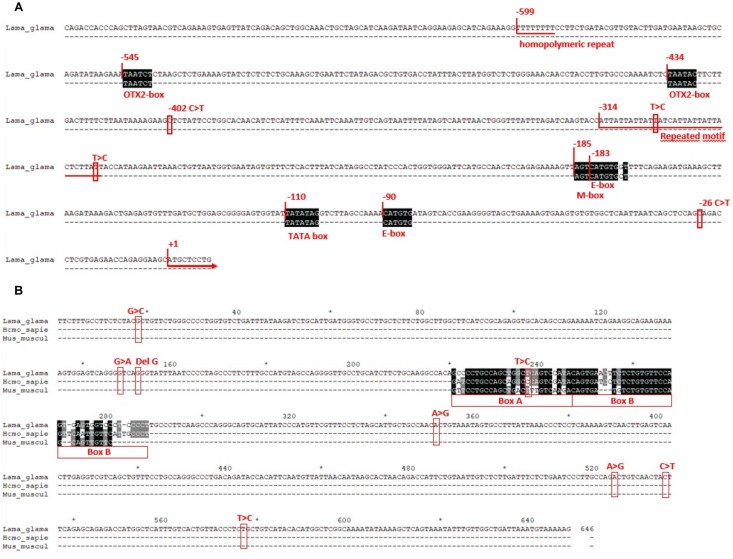
(A) Proximal promoter region of TYR gene. Positions +1 were assigned to the translation initiation site (ATG codon). Regulatory elements are aligned with its consensus sequence in black blocks and named underneath. Numbers above the elements indicate relative positions. Red squares indicate the location of the SNPs found in llamas and the repeated elements are underlined. (B) TYR LCR region. Nucleotide positions (from 1 to 646) are indicated in black above the sequence. Number 1 was arbitrarily designed to the first nucleotide showed. Boxes A and B are aligned to the ones of mouse and human (X76647 and AY180962) and the variation found in llamas is squared in red color.